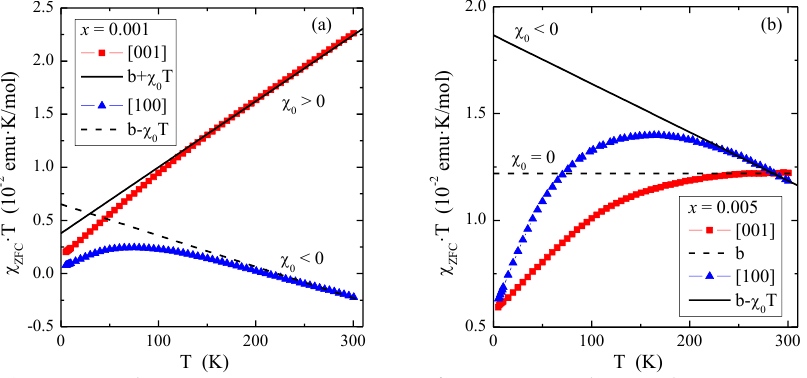
Figure 3. Product  ZFC  T vs. temperature T of PNMWO single crystals: a) x =0.001 and b) x -0.005. The 229 Figure 3. Product χ ZFC · T vs. temperature T of PNMWO single crystals: ( a ) x = 0.001 and ( b ) x = 0.005. solid and dashed lines,  T (T), indicates Curie-Weiss behavior.  0 is the temperature independent 230 The solid and dashed lines, χ · T(T), indicates Curie-Weiss behavior. χ 0 is the temperature independent contribution of magnetic susceptibility. contribution of magnetic susceptibility.